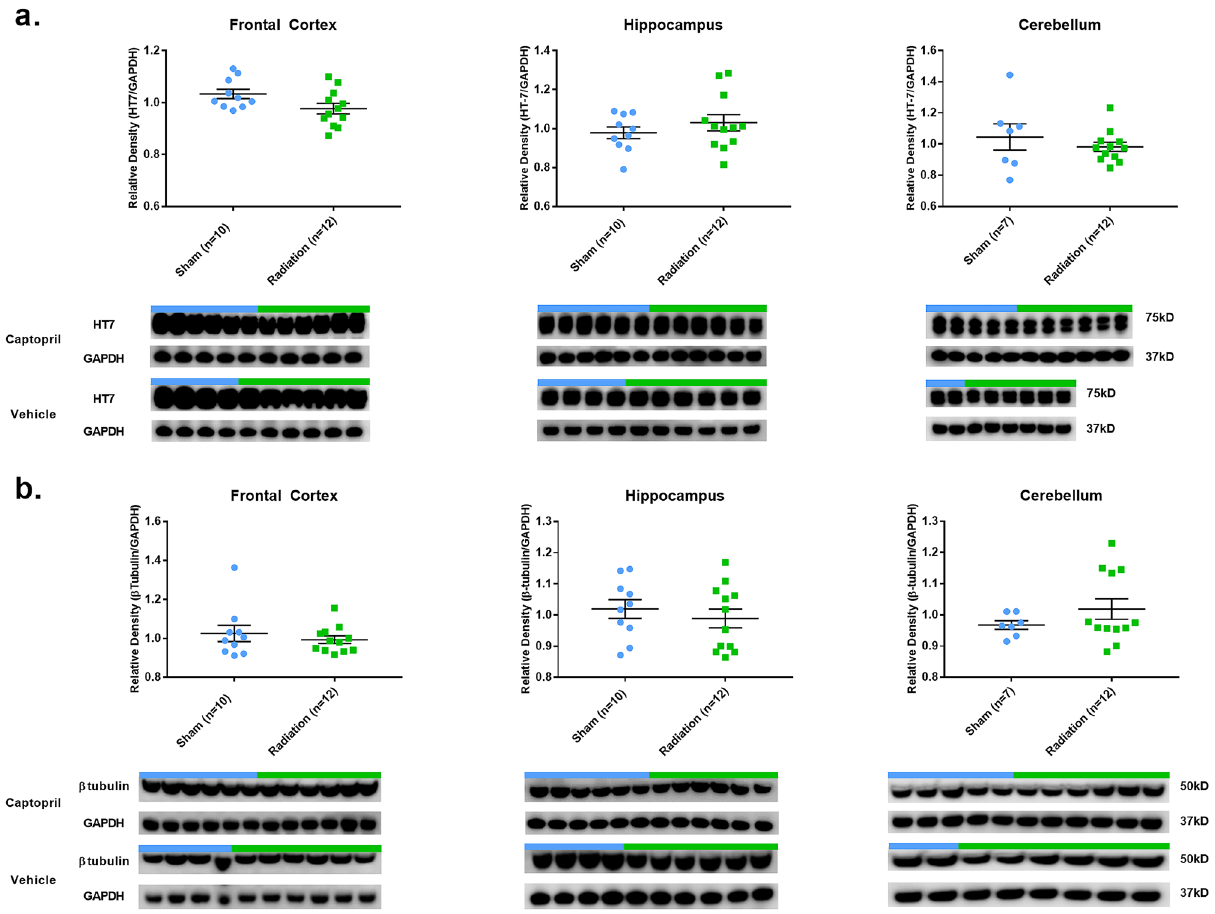
Figure 2. Total-Tau and β-tubulin expression in brain following total body radiation. Histograms representing the densitometric ratio of levels of (a) total Tau (HT7) and (b) β -tubulin with respect to GAPDH as measured in the frontal cortex, hippocampus and cerebellum in the brains of Gottingen mini-pigs 30-days after total body radiation (1.79 Gy of Cobalt [ 60 Co]) with representative western blots # for sham and radiation exposed animals treated with captopril or vehicle. There was no statistical difference between captopril or vehicle treated groups, so data was pooled for each group represented in histograms above. *indicates p values < 0.05 as determined by 2-tailed, unpaired, t-tests. Error bars represent standard error of the mean (SEM). # for full length blots for each antibody, see Supplementary Fig.